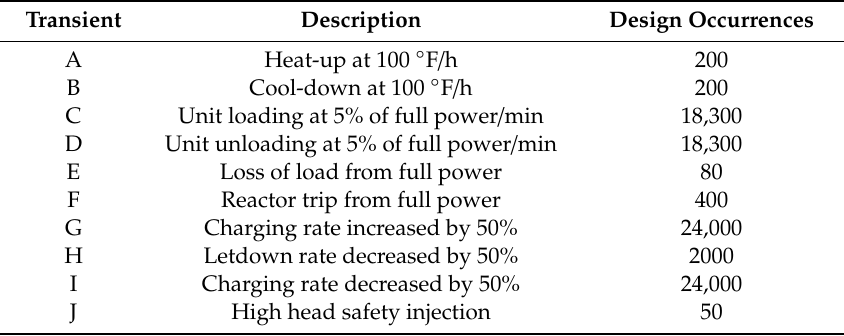
Table 1. Transients considered in the analysis and design